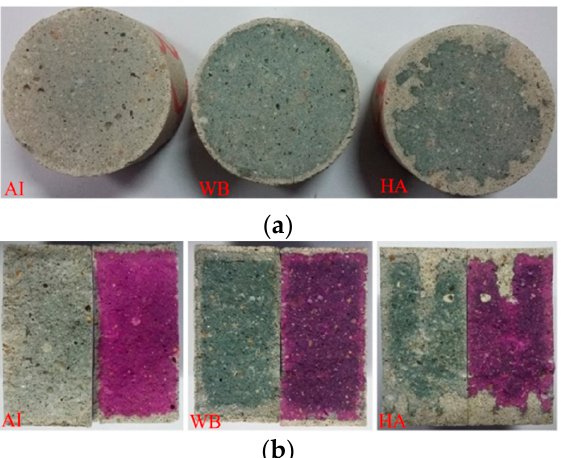
Figure 5. Sectional drawings of the eroded samples: ( a ) cross-section and ( b ) vertical section.